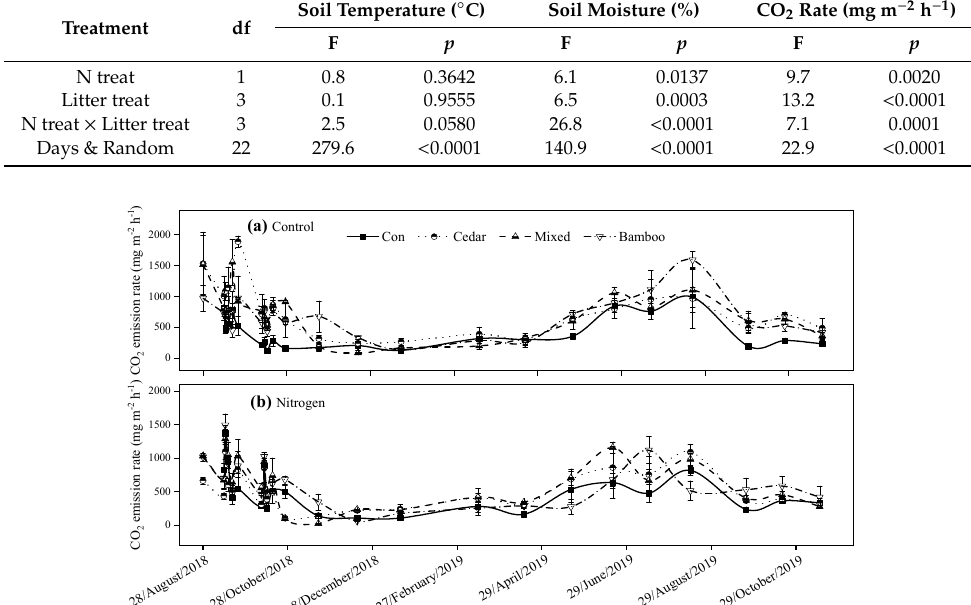
Table 2. The dependence of soil temperature (°C), soil moisture (%), and soil CO 2 emission rates (mg m − 2 h − 1 ) on N and fine root litter treatments in analysis of variance with measure time (days) as random effects.